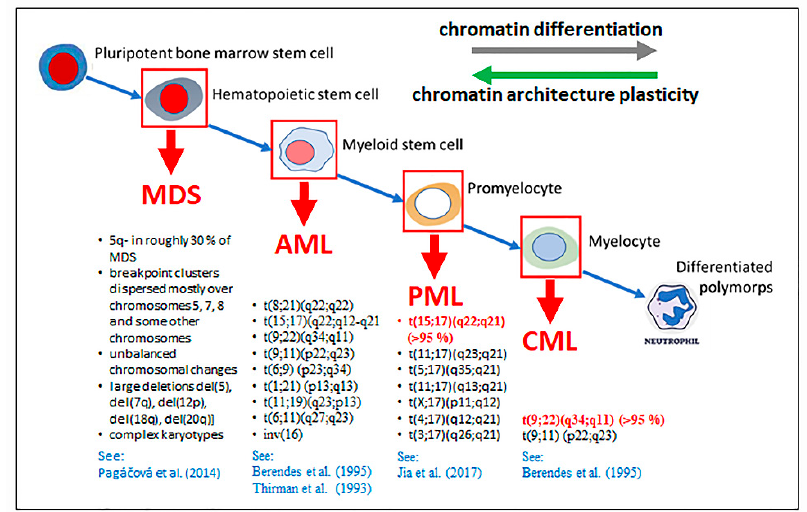
Figure 15. The relationship between the differentiation stage of particular leukemia cell type pre ‐ cursors, chromatin network plasticity of these precursors, and variability of genetic defects associ ‐ ated with a given type of leukemia [85–88]. Abbreviations: MDS: myelodysplastic syndromes, AML: acute myeloid leukemia, APL: acute promyelocytic leukemia, CML: chronic myeloid leuke ‐